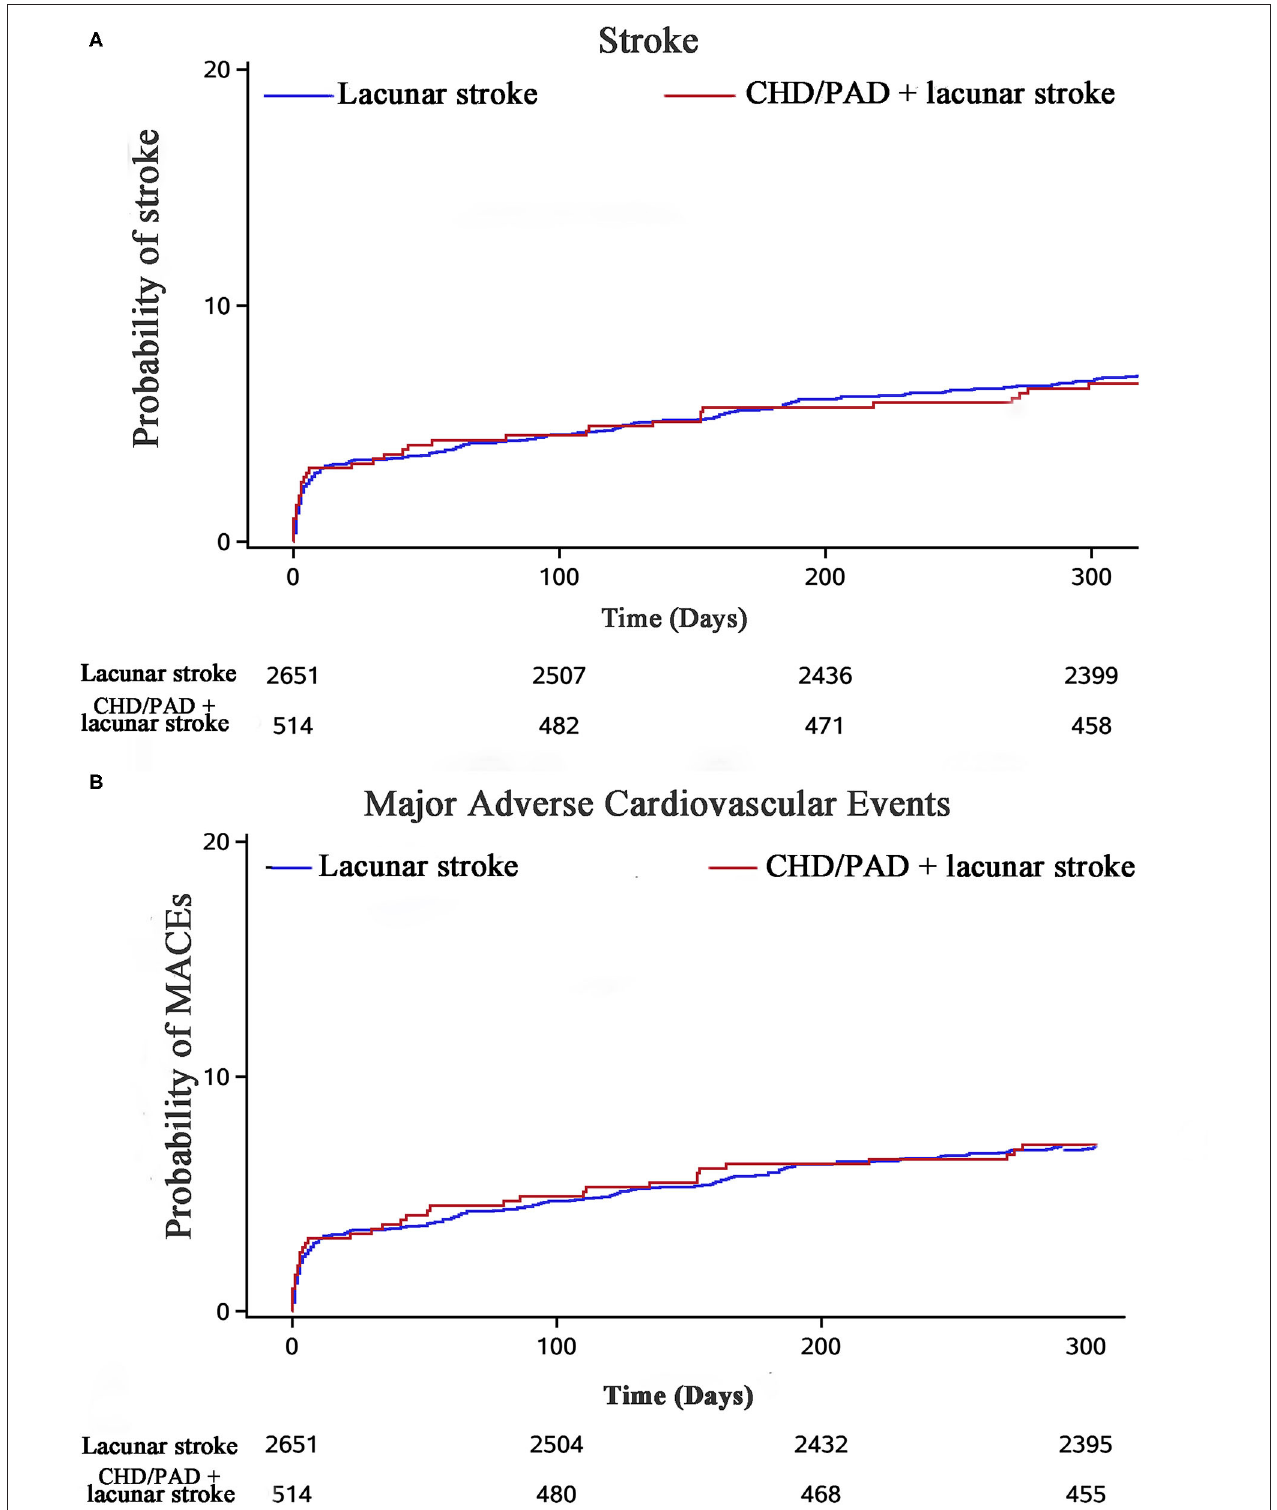
FIGURE 3 | Stroke recurrence and MACEs in the study population stratified by polyvascular disease at 1 year.